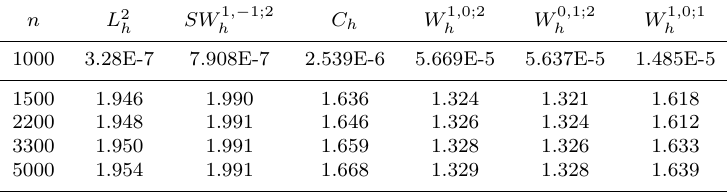
Table 9. Practical errors and error orders in Example A